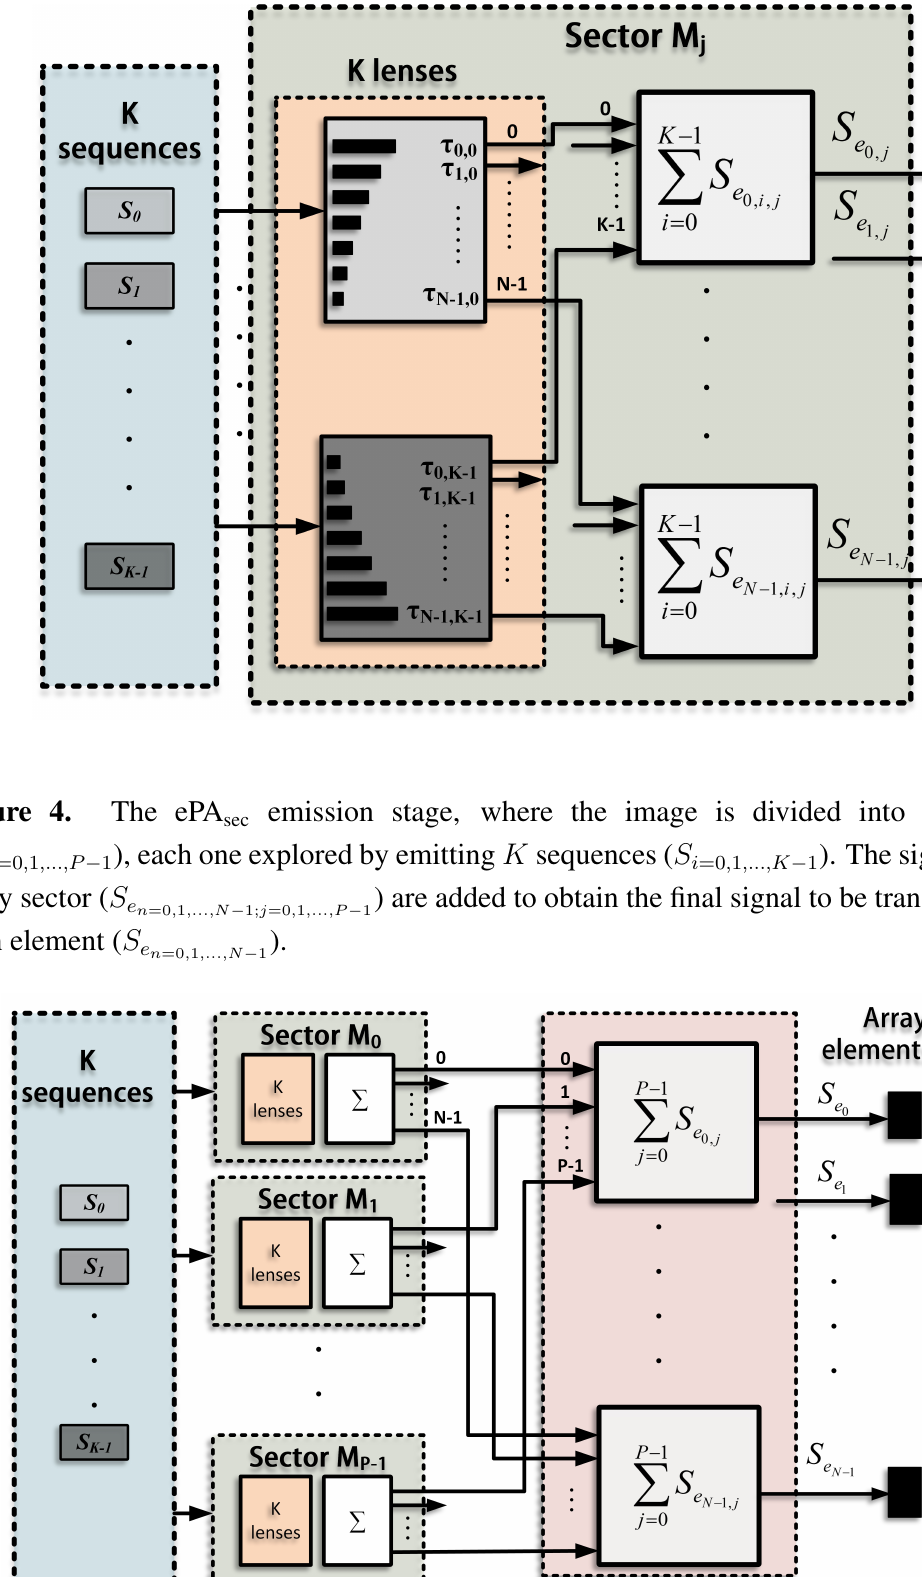
Figure 3. Detail of the emission process in a sector, M . The sector is explored by emitting j K sequences ( S ), where a different lens is applied to each sequence to scan K i =0 , 1 ,...,K − 1